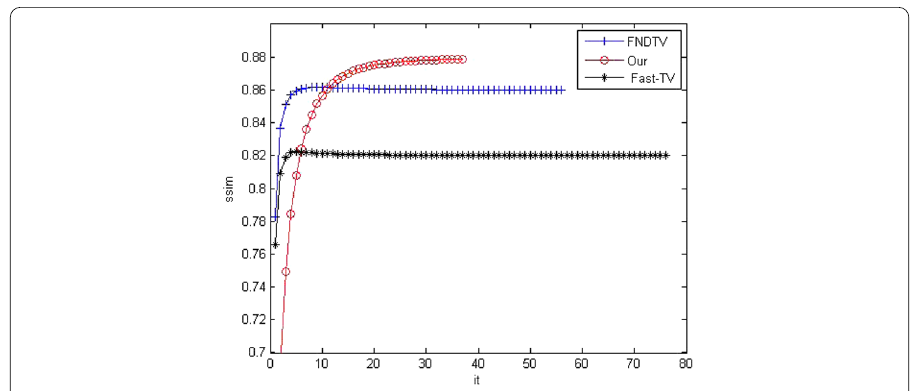
Figure 9 Changes of SSIM value versus iteration number for the three methods about motion blur with theta = 100